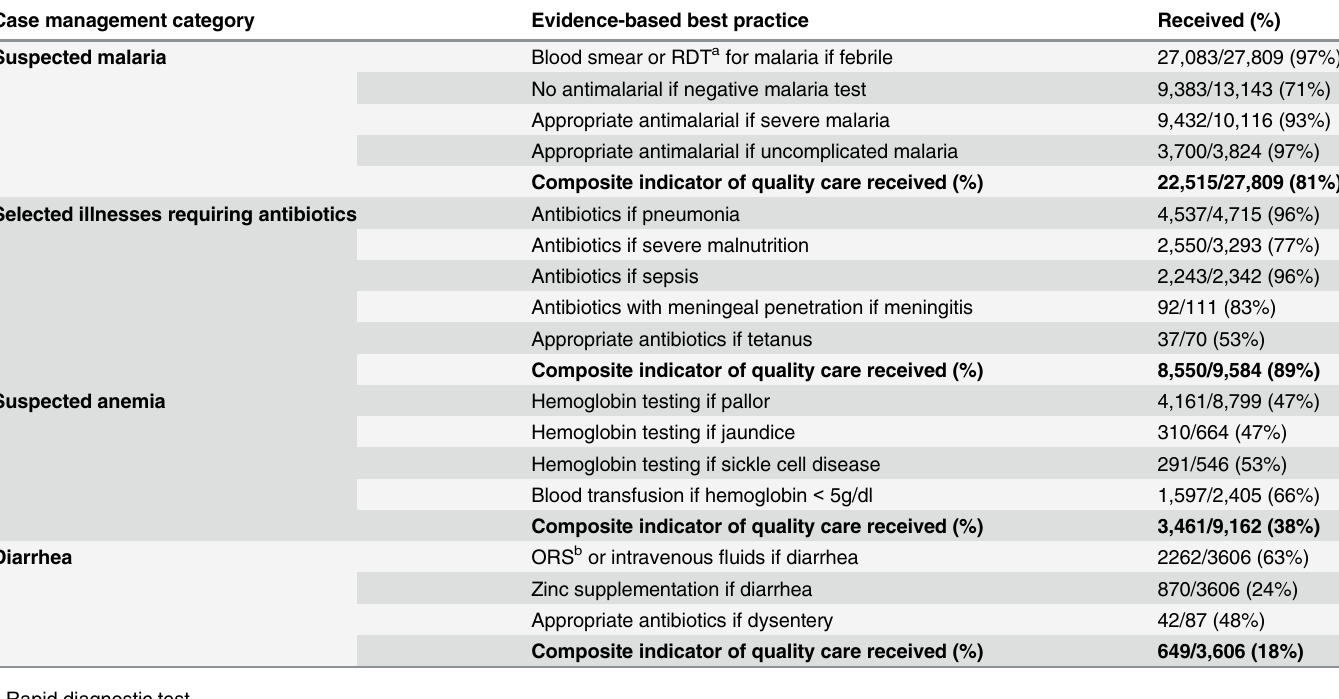
Table 3. Inpatient case management best